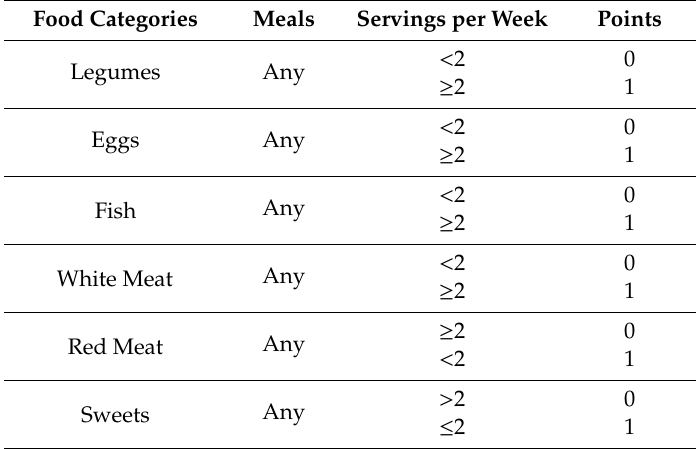
Table A3. Scoring of food groups counted on a weekly basis. Food Categories